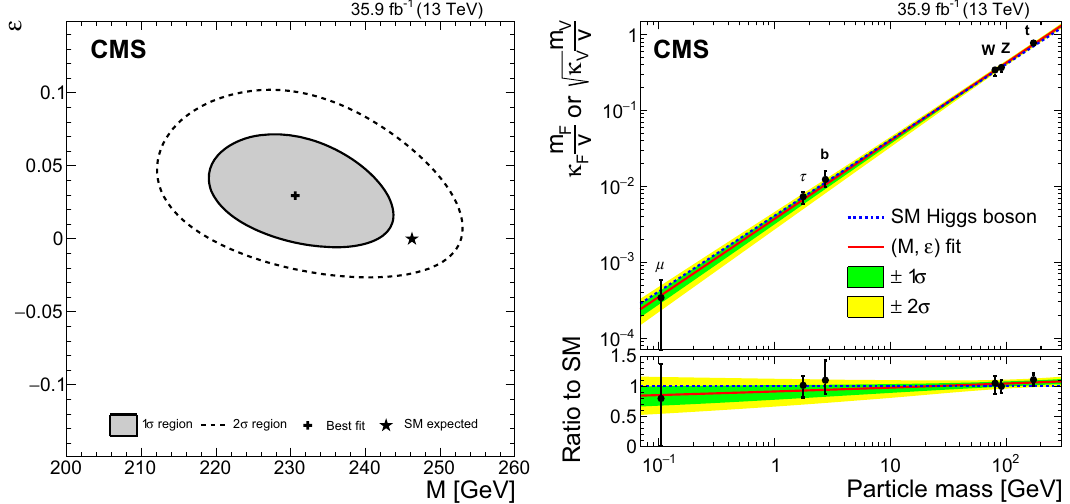
Fig. 10 Likelihood scan in the M - (cid:14) plane (left). The best fit point and the 1 σ and 2 σ CL regions are shown, along with the SM prediction. Result of the phenomenological ( M ,(cid:14)) fit overlayed with the resolved κ -framework model (right) Fig. 11 Summary plots for the κ -framework model in which the ggH and H → γγ loops are scaled with effective couplings. The points indicate the best fit values while the thick and thin horizontal bars show the 1 σ and 2 σ CL intervals, respectively. In the left figure the constraint = 0 is imposed, and both B BSM positive and negative values of κ κ W and Z are considered. In the right figure a constraint | κ | , | κ | ≤ 1 is imposed W Z (same sign of κ W and κ Z ), while > 0 and B > 0 are B inv undet